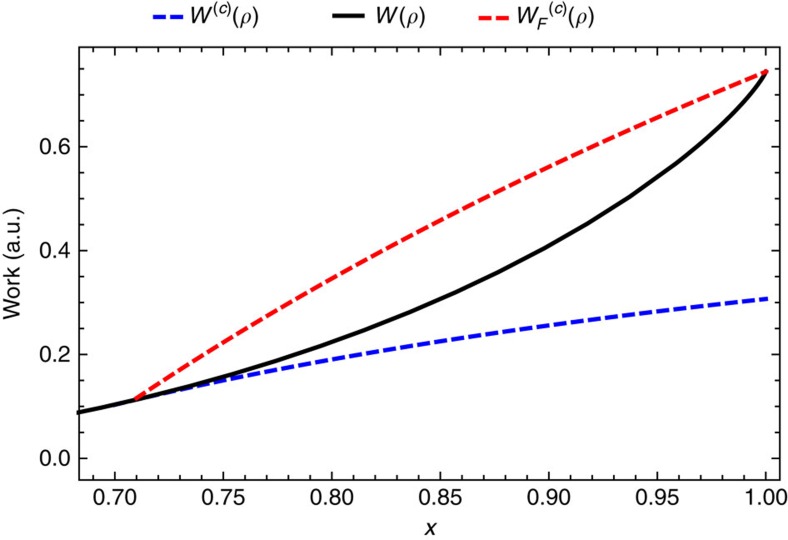
Variation of c-bounded work extraction and state formation further from equilibrium.Figure shows the unbounded work W(ρ), the c-bounded work content W(c)(ρ) and the c-bounded work of formation (ρ) for the state  with Hamiltonian  with β=1,  and c=0.7. Note that despite choosing a c-bound that allows for fluctuations of the order of the maximal work that can be extracted from the pure state x=1, in general we can extract much less that this amount. There is a discontinuity in W(c)(ρ) at x=0 where we recover W(c)(ρ)=W(∞)(ρ). Notice also that closer to the thermal state the dissipation (difference between the W(c)(ρ) or (ρ) and W(∞)(ρ)) is greater for state formations than work extraction, and this reverses as the state moves further from the Gibbs state.